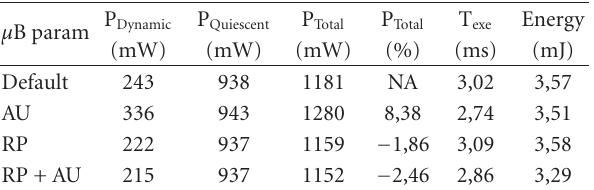
Figure 22: Impact of the clock frequency onto the overall energy consumption of a uniprocessor design executing the NCC algorithm on a V5LX110T. Table 5: Impact of the MicroBlaze configurations ( µ B param) for the Quicksort algorithm at 100 MHz for V4FX100.